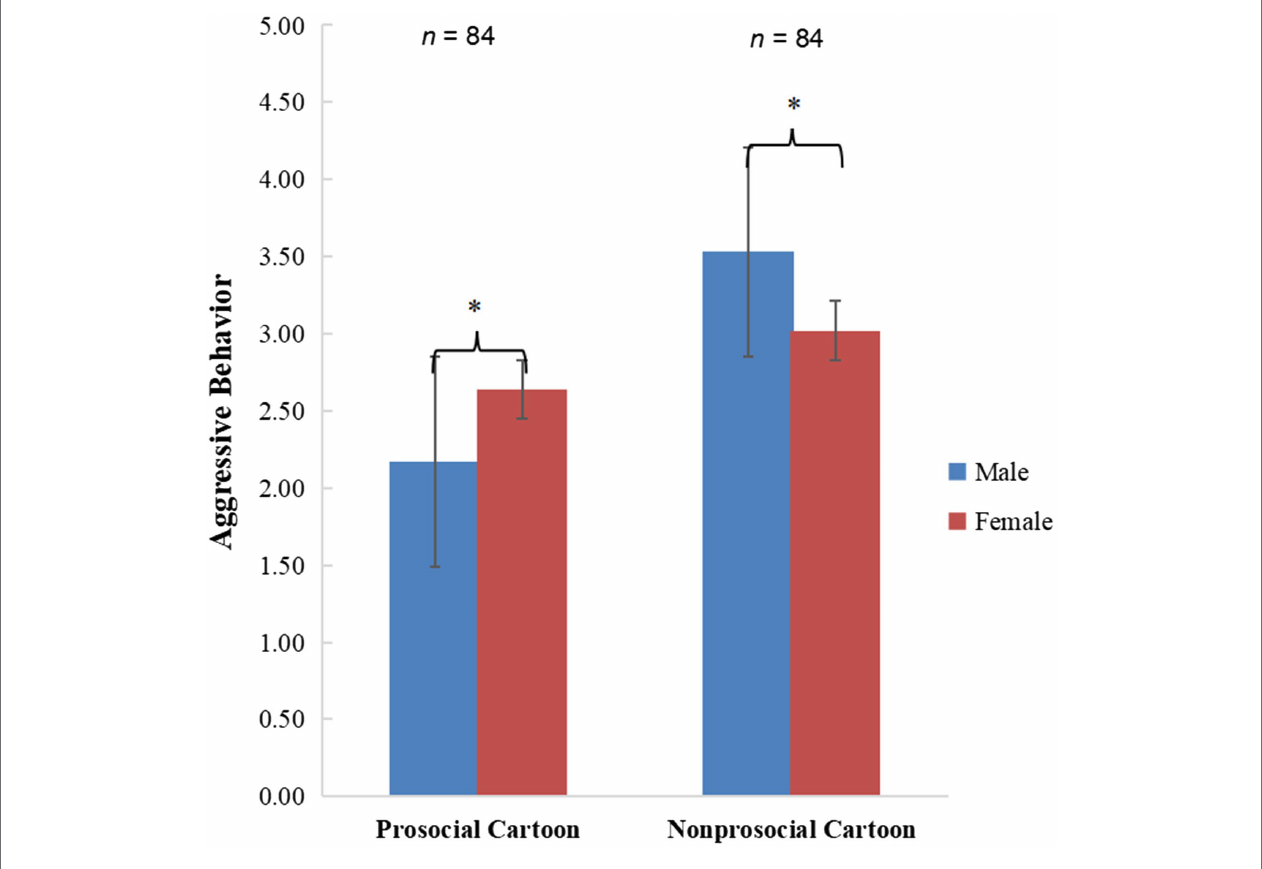
FIGURE 1 | Cartoon × gender interaction on aggressive behavior. * p <